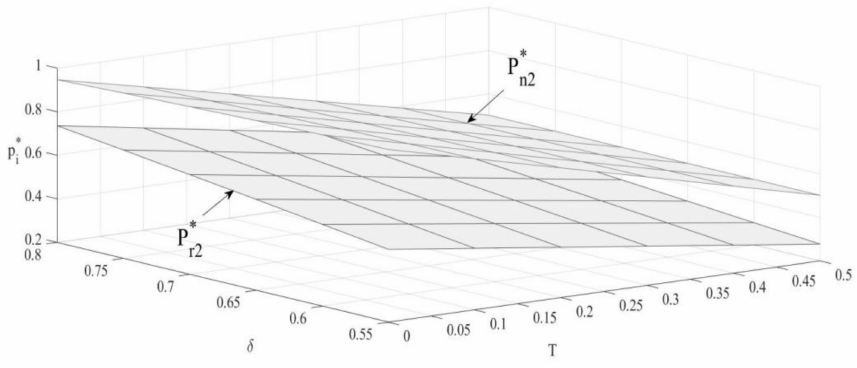
Figure 1. The impact of T and δ on unit sales